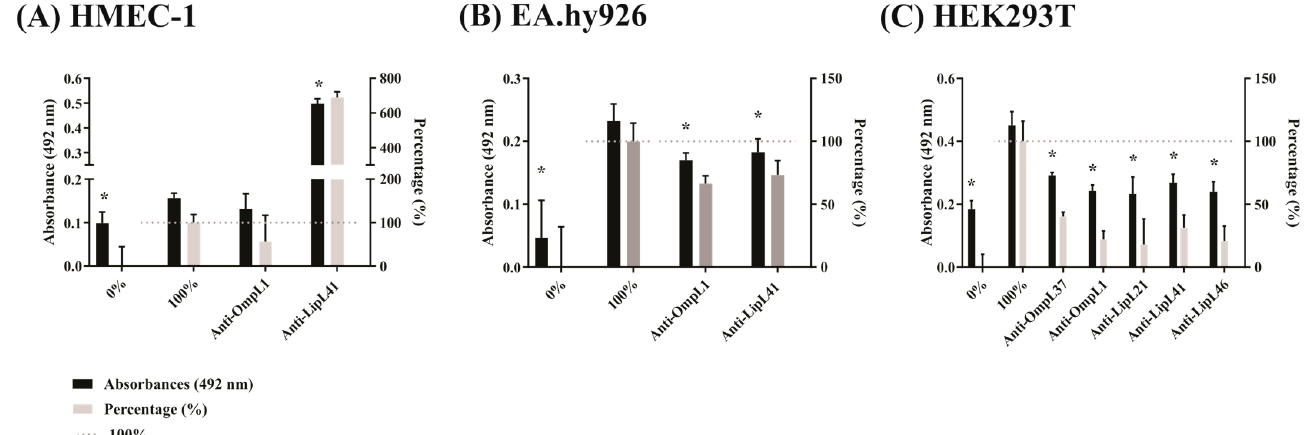
Figure 5. The interaction of leptospires with human cells was affected by polyclonal antibodies against the recombinant proteins. Leptospires (10 7 leptospires/well, MOI 100) were incubated with polyclonal antibodies produced in mouse (1:100) for 1 h. Binding of bacteria was assessed in 96-well plate with cell monolayers (10 5 cells/well) for 2 h. Wells without and with addition of untreated leptospires were used as controls. Samples were incubated with anti-LipL32 produced in hamster (1:1000). The reaction was detected with anti-hamster IgG-peroxidase. Values were represented by percentage considering the wells without and with the addition of leptospires as 0 and 100% of adhesion, respectively. The binding of the bacteria was compared to the 100% control by the two-tailed t -test ( p < 0.05) showed by *. ( A ): HMEC-1, ( B ): EA.hy926, ( C ): HEK293T.